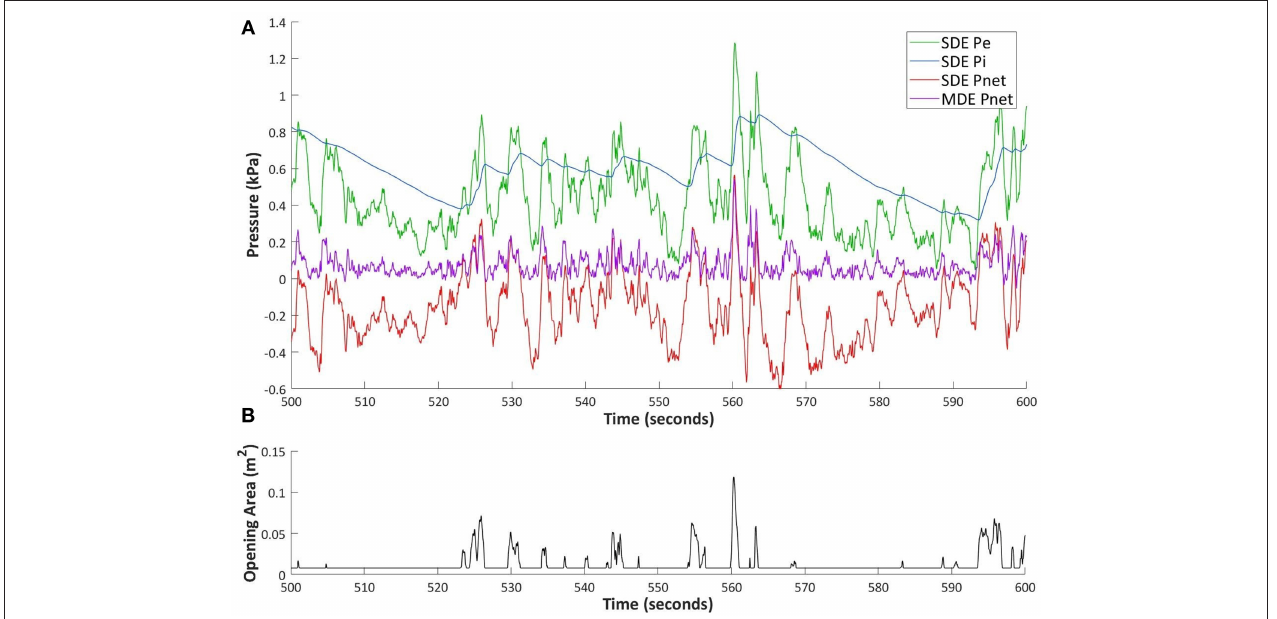
FIGURE 11 | Time-histories of (A) external, predicted internal, and net pressure for the SDE using a flexible garage door, and the net pressure for the MDE for a fixed garage door opening of 1% of door area, and (B) the open area as a function of time for the flexible garage door.